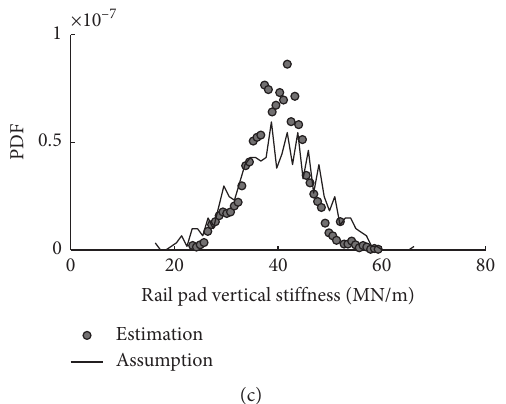
Figure 14: Comparisons between estimation and measurement estimated by the rail vertical displacement. (a) CV � 0.05; (b) CV � 0.10; (c) CV � 0.20.